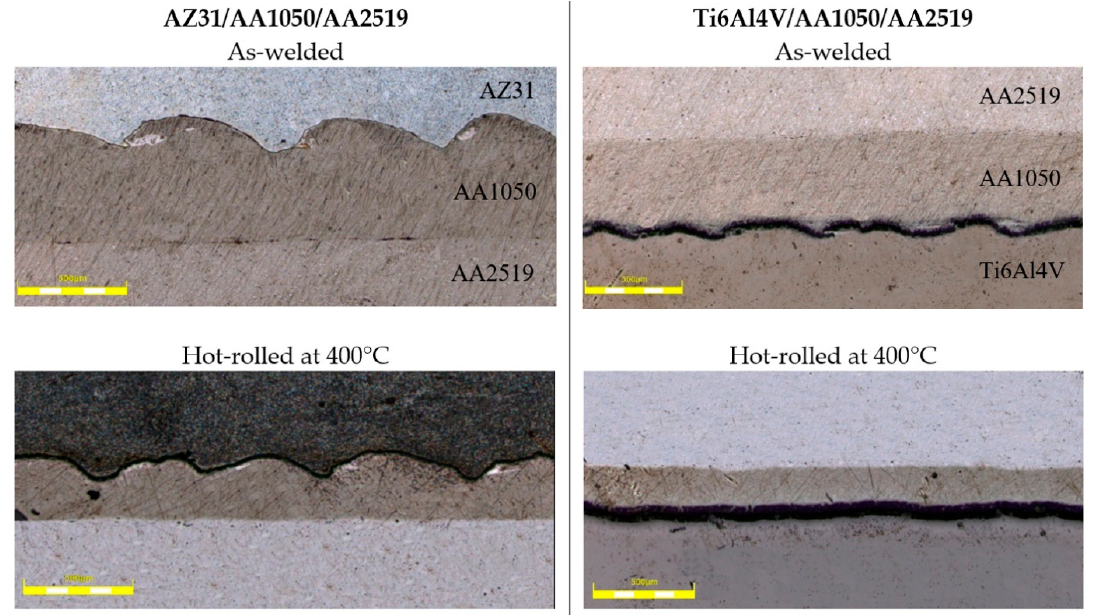
Figure 10. Light microscopy images of investigated interfaces (500 µm scale bar).